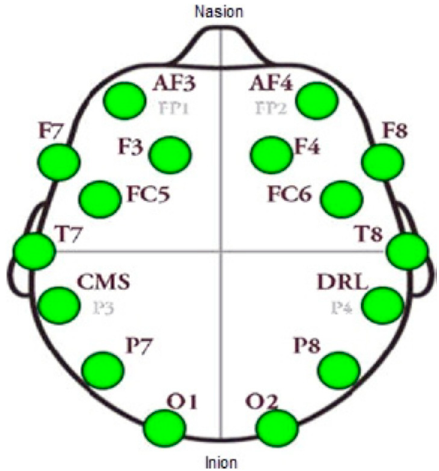
Figure 2. Electrodes placement of Emotiv EPOC according to 10–20 system.